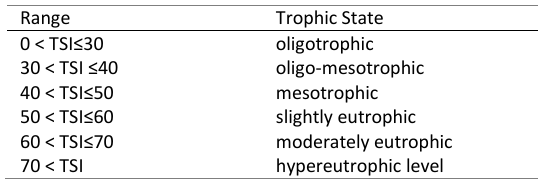
Table 1: Trophic State Index (TSI) (Carlson, 1977)